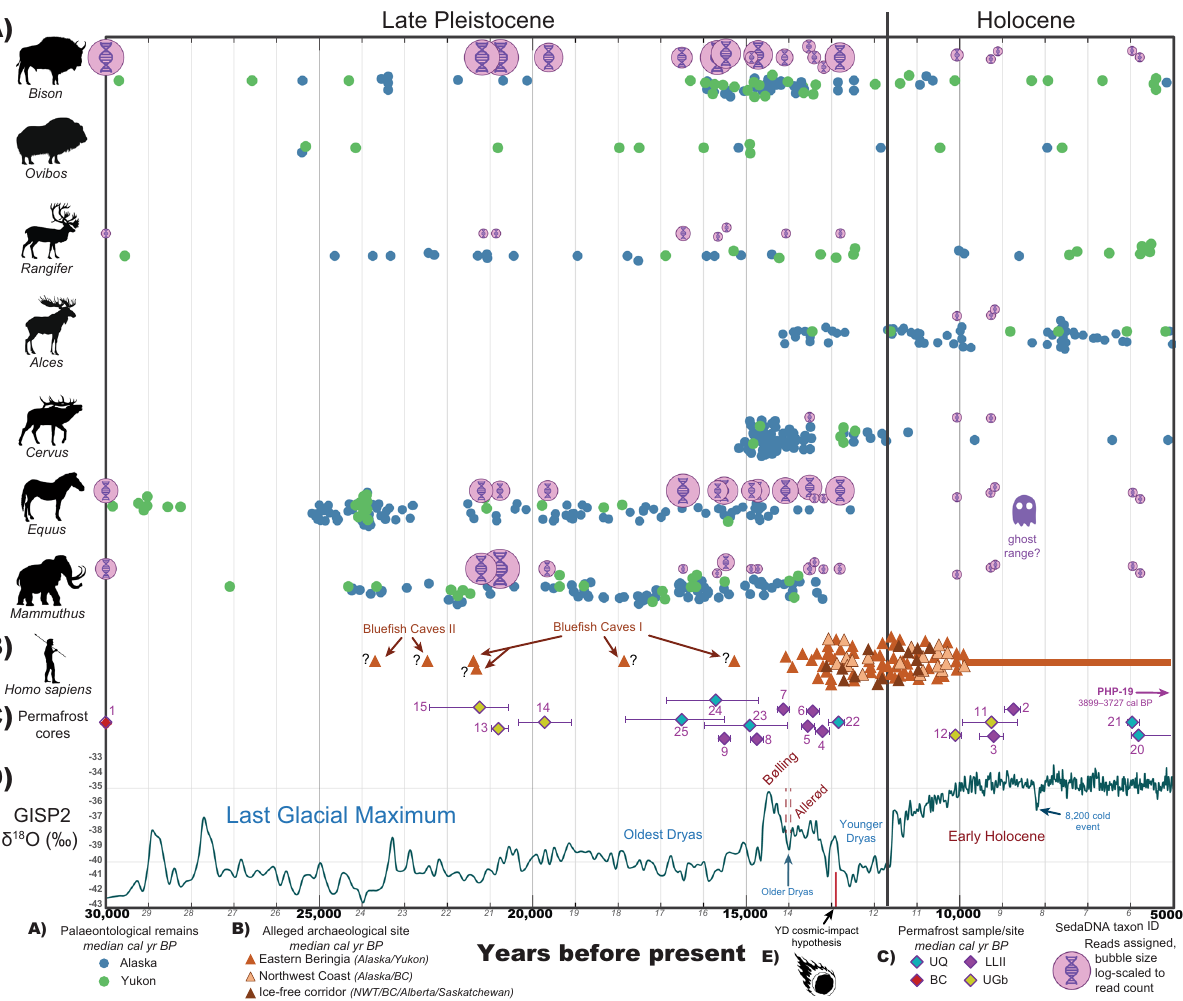
Fig. 7 Synthesis of palaeontological, archaeological, climatological, and megafaunal sedaDNA data. Source data are provided as a Source Data fi le, see the following references for original data sources. A Dated fossils of select megafaunal taxa in eastern Beringia 165 , see Supplemental Fig. 1. B Earliest archaeological sites in northwestern North America 188 , see Supplemental Figs. 2 – 3 and Supplemental Table 2. C Central Yukon permafrost samples analyzed in this study with 2 σ modelled age ranges, see Supplementary Figs. 5 – 7. D Greenland Ice Sheet Project 2 (GISP2) oxygen isotope pro fi les at 2 m intervals 189 . E Onset of the Younger Dryas, and alleged cosmic impact hypothesis 190